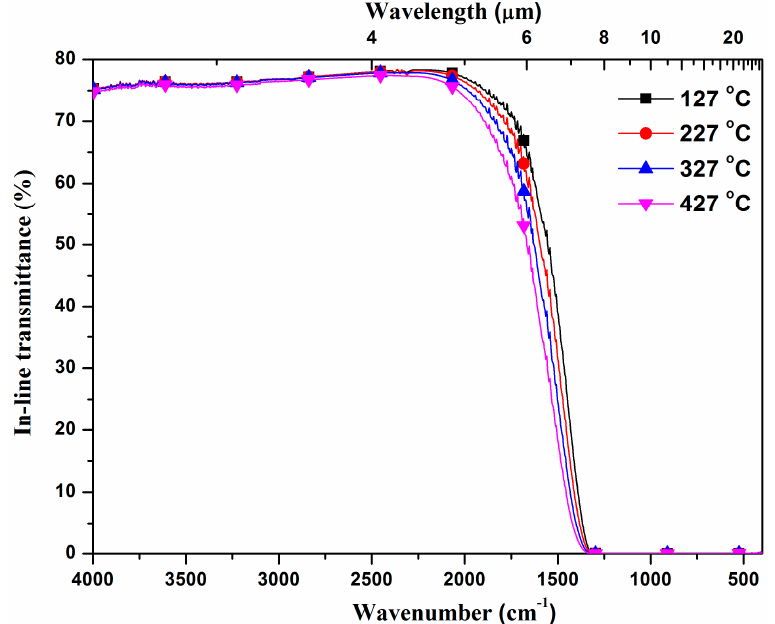
Figure 6. In-line transmittance of 3Y-TZP ceramics in the elevated temperature range from 127 °C to 427 °C.